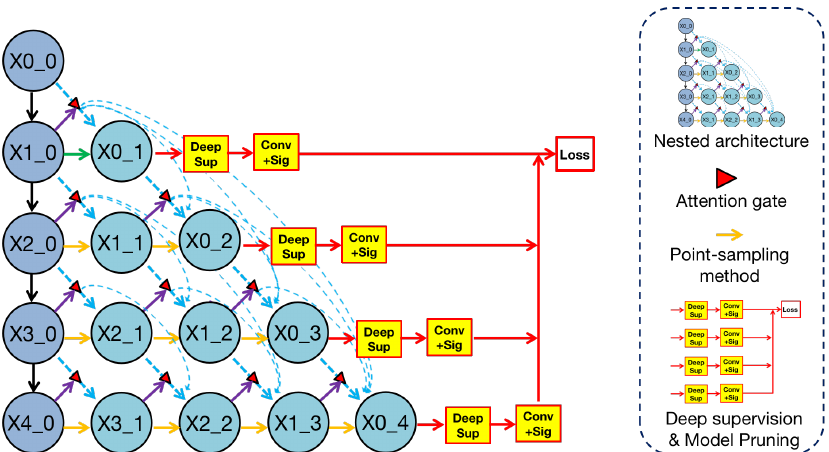
Figure 1. Overview of methodologies in Render U-Net. Nested architecture is analyzed in Section 3.1. Attention mechanism is analyzed in Section 3.2. The point-sampling method is analyzed in Section 3.3. Deep supervision is analyzed in Section 3.4. Model pruning is analyzed in Section